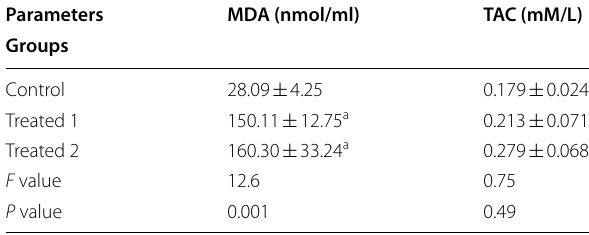
The data are presented as a mean and standard error of the mean a P 0.05 as compared with =